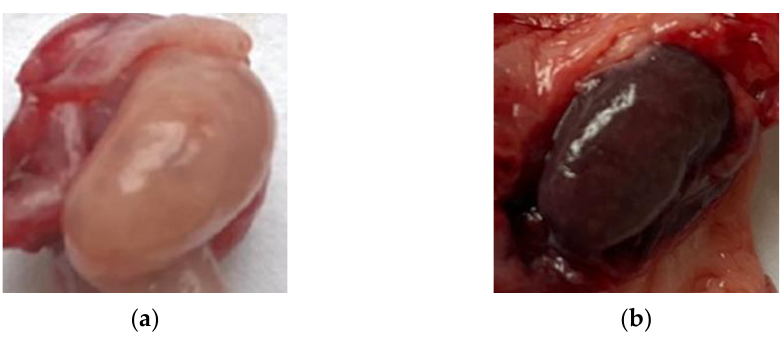
Figure 2. Photos of the studied clinically healthy cat ovaries: ( a ) light; ( b ) dark.